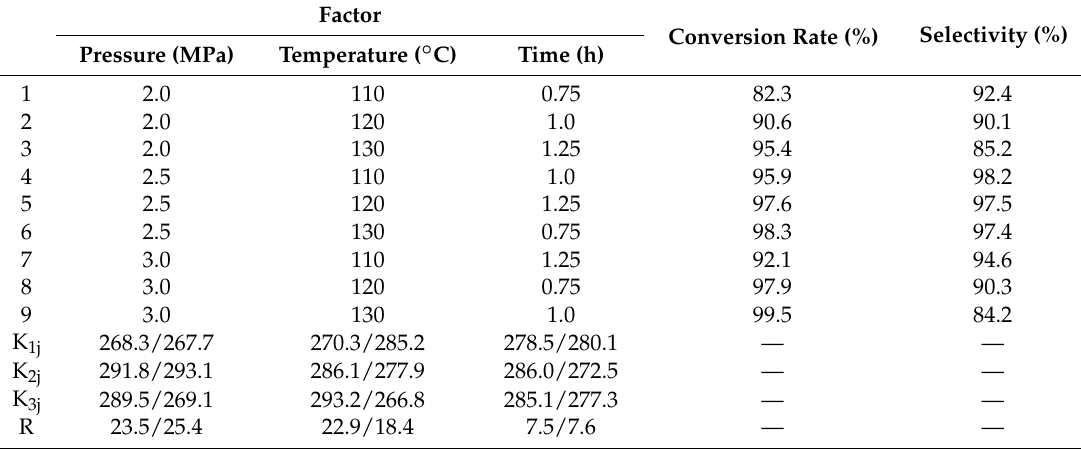
Table 2. Orthogonal test-effects of reaction conditions on catalytic performance.